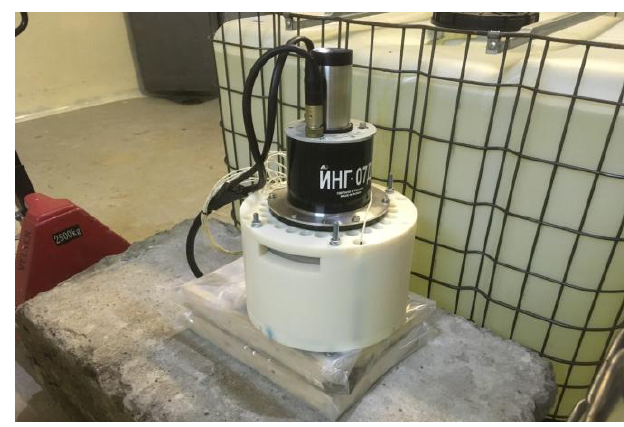
Fig.1 Experimental detector of FM in concrete structures.